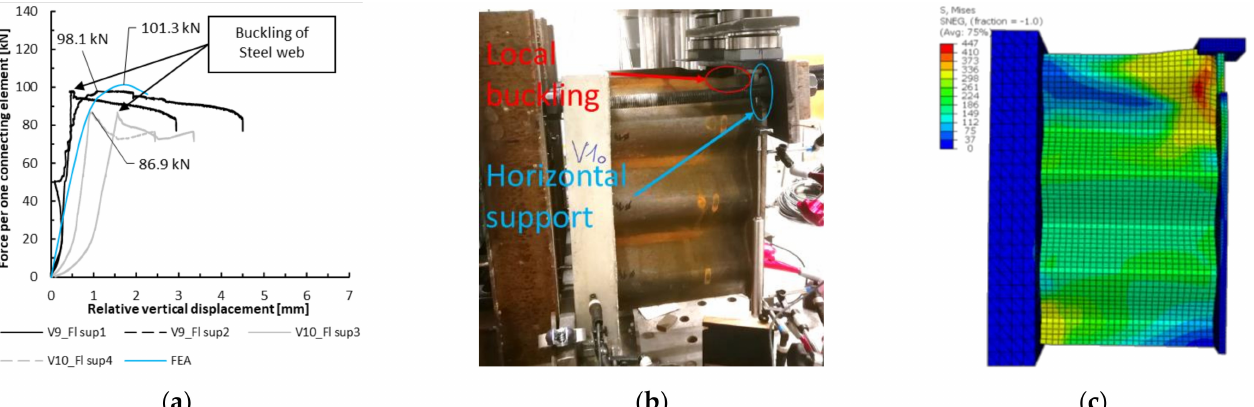
Figure 10. Test results: concrete panel and SIN beam, with horizontally supported steel flange ( a ) load-deformation diagram with results from laboratory tests (black and grey) and FE-simulations (blue); ( b ) specimen post failure in the laboratory test with local buckling of the steel web and horizontal support at the steel flange; ( c ) finite element specimen post failure, deformation superelevated two times.